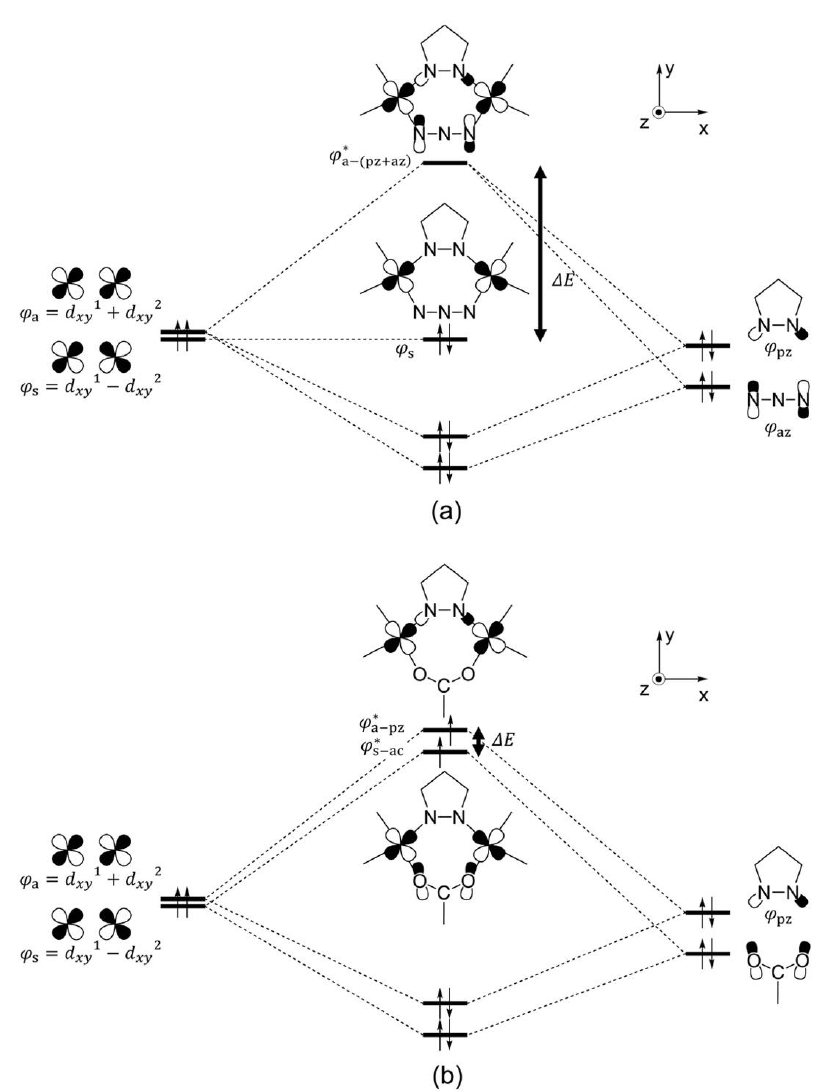
Figure 2. Schematic representation of orbital interactions for ( a ) complementarity and ( b ) counter-complementarity found in complexes 1 and 2 , respectively.